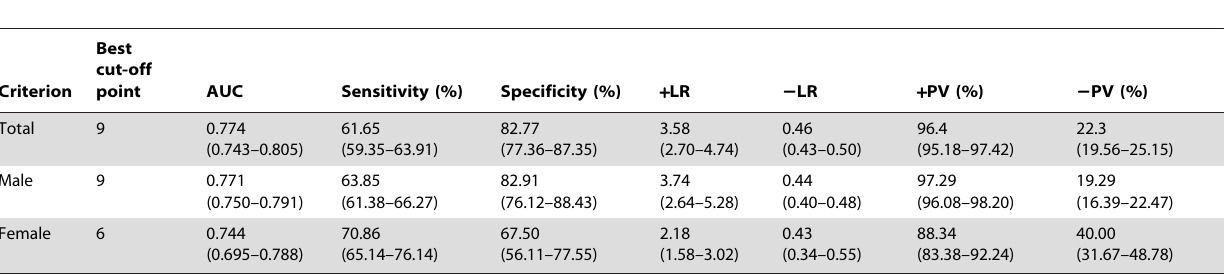
Table 2. The efficiency for detecting OSA with ESS versus PSG for the total subjects (n=2,032), male subjects (n=1,674) and female subjects (n=358) in the test